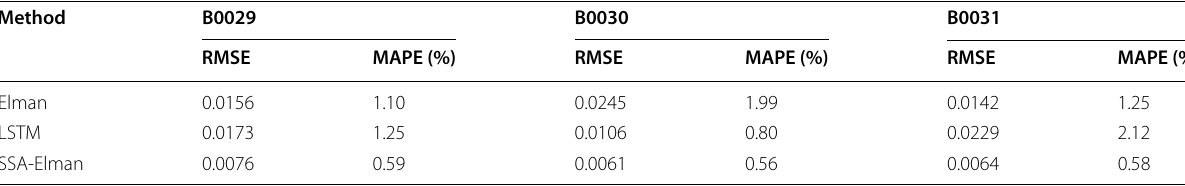
Table 11 Estimation errors at high